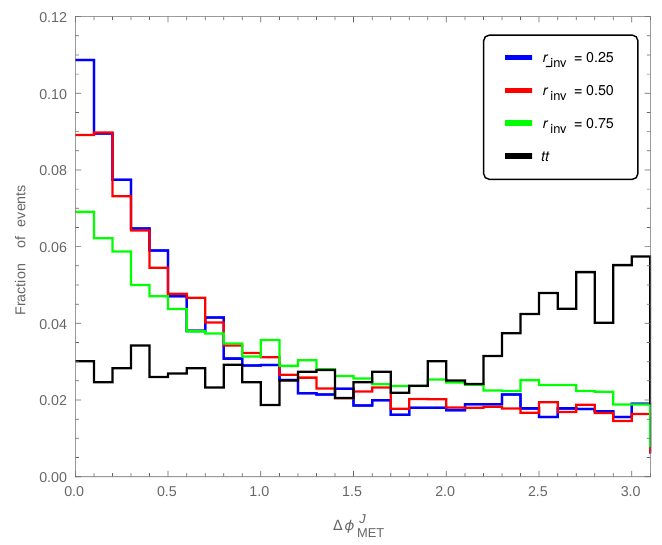
Figure 6. Normalized distribution of (cid:1) (cid:30) J in case II for di(cid:11)erent signals and the t (cid:22) t background. MET The mediator was taken to be X S with a mass of 300 GeV. The cuts of ref. [46] for the lowest L inclusive signal region for 2 same (cid:13)avor leptons and 0 jets were applied beforehand, except the veto on jets and